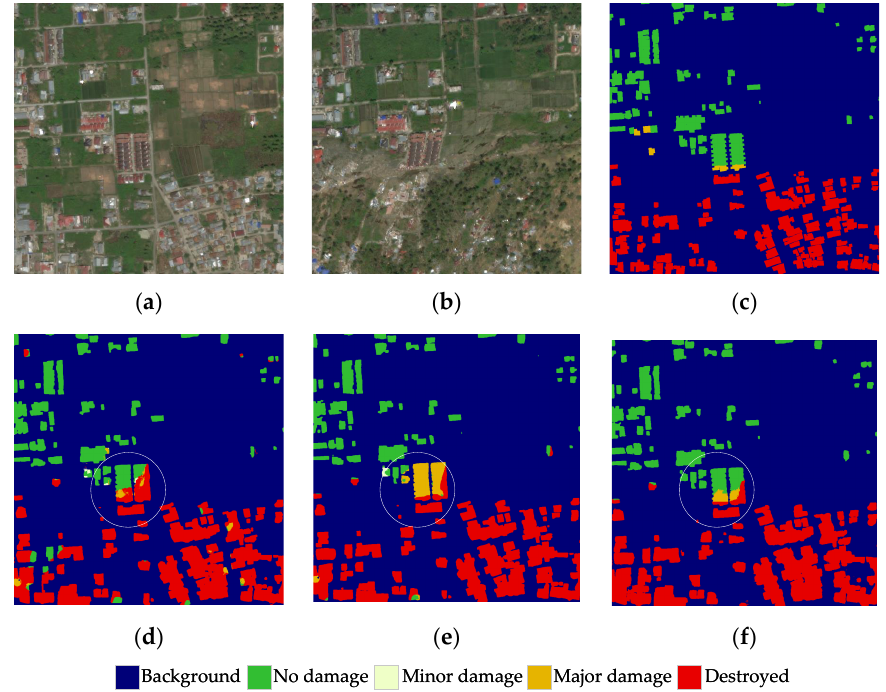
Figure 10. The visual comparison of prediction results on palu-tsunami in xBD dataset. ( a ) Pre- disaster; ( b ) post-disaster; ( c ) ground truth; ( d ) baseline; ( e ) SDAFormer (without SF); ( f ) SDAFormer (with